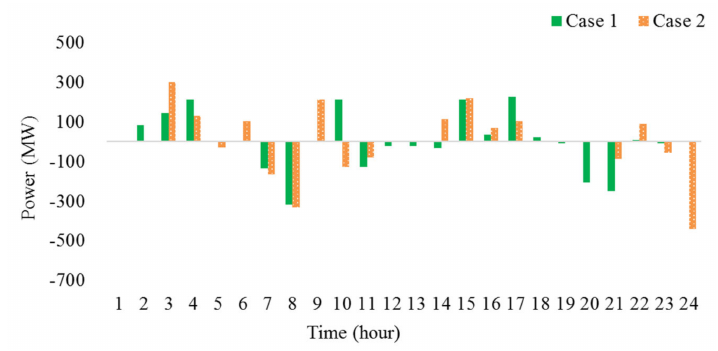
Figure 14. The power outputs of BES in Case 1 and Case 2.